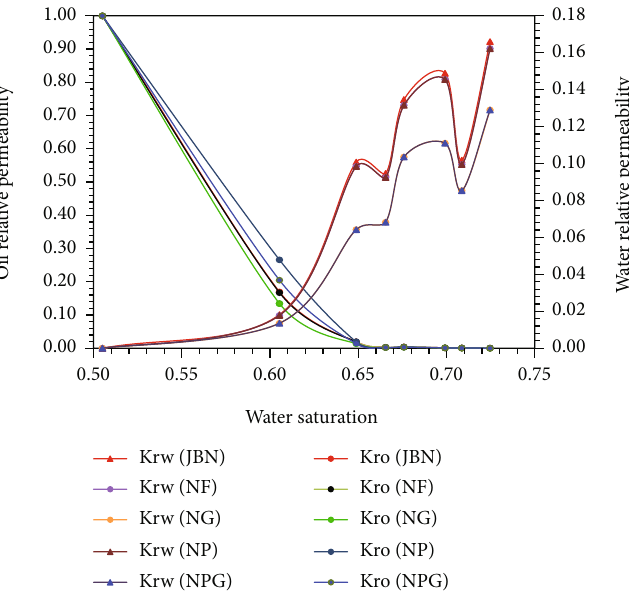
Figure 4: Curves of relative permeability based on the traditional JBN method and the improved JBN